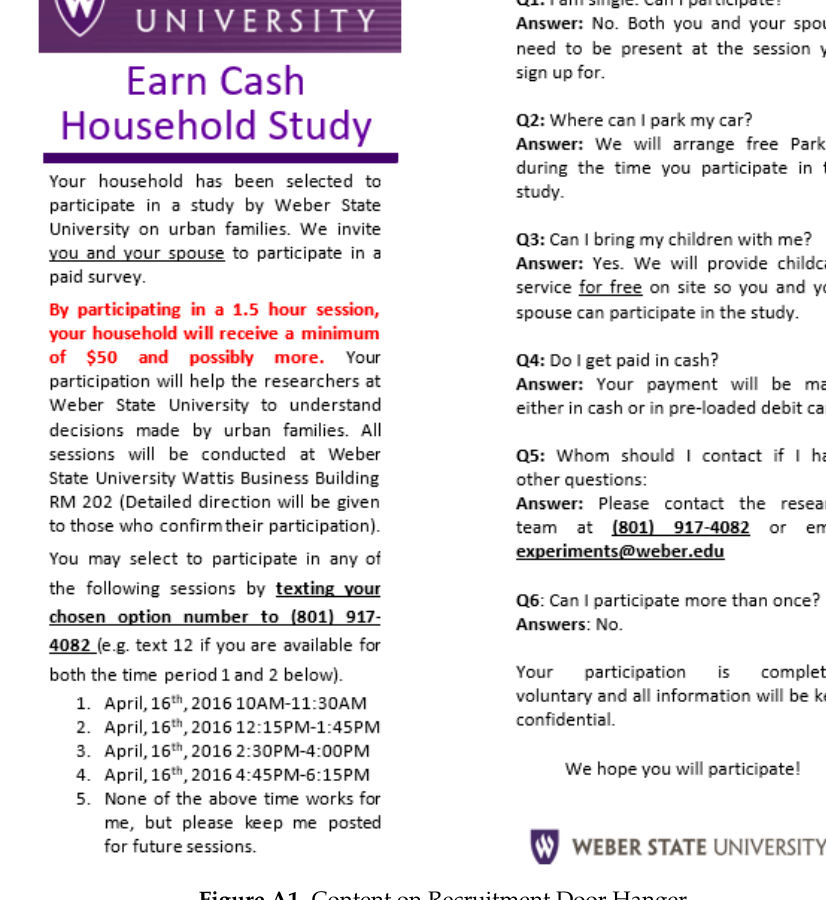
Figure A1. Content on Recruitment Door Hanger.